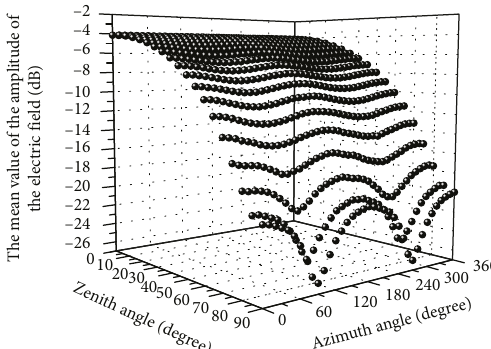
Figure 13: The mean value of the amplitude of the electric fi eld for di ff erent inclination angles in the NLOS corridor.